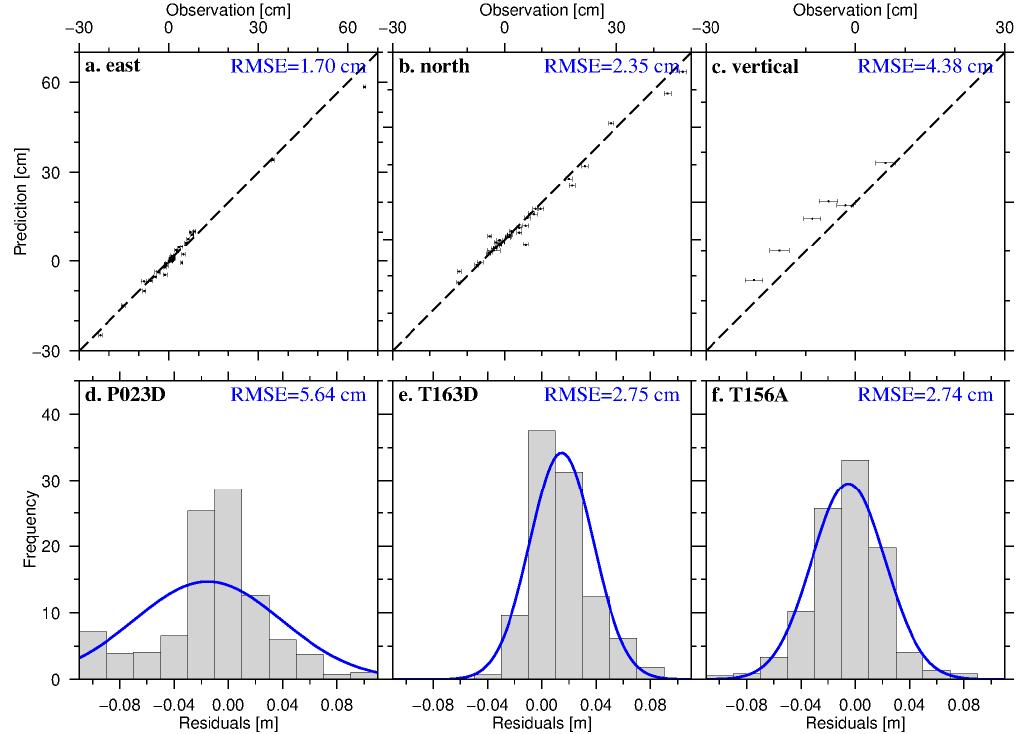
Figure 7. Results of GPS and InSAR data fittings. ( a–c) Comparison of the observations of GPS data and the predictions from the preferred model. ( d–f ) Histograms of residuals after subtracting the model predictions from the observations of InSAR data.